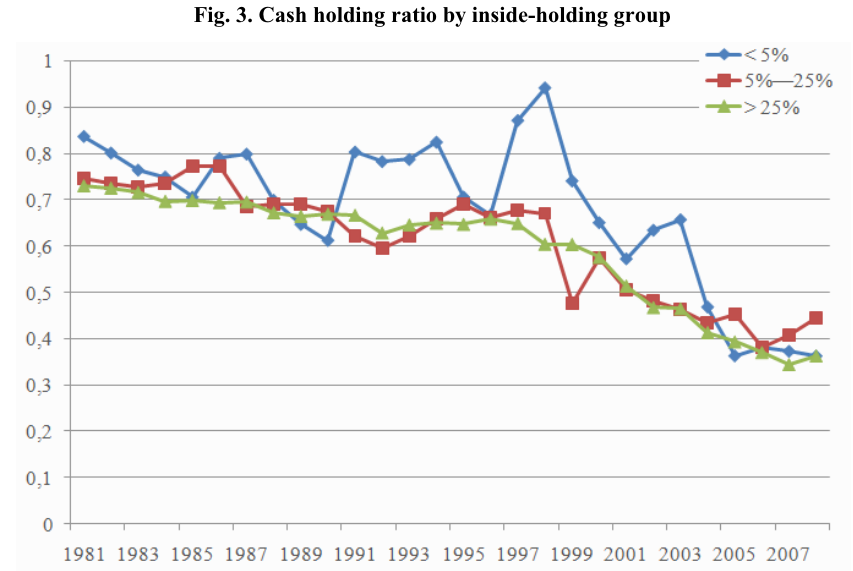
Fig. 3. Cash holding ratio by inside-holding group